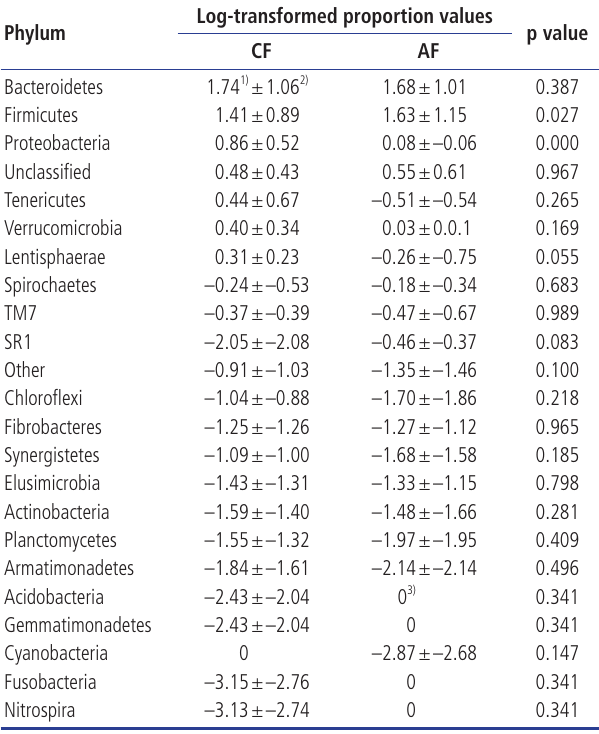
Table 2. The bacterial compositions and their relatively abundance at the phylum level in the rumen of goats fed a completed feed (CF) or all forage (AF)